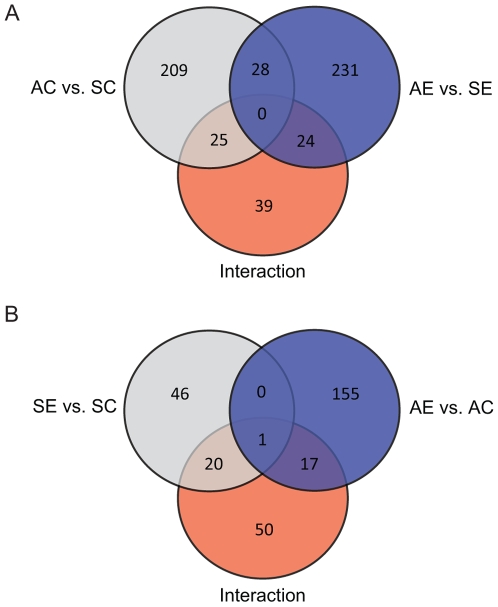
Venn-diagram of regulated cDNA spots in different seasons and with simulated territorial intrusions.A) Number of regulated cDNA spots in autumn compared to spring in either control or STI groups (AC vs. SC, 262 total; AE vs. SE, 283 total), and those that showed interaction effect of season and STI (88 total). B) Number of regulated cDNA spots in STI compared to controls in each season (SE vs. SC, 67 total; AE vs. AC, 173 total), and those that showed interaction effect of season and STI. The numbers within the overlapped circle indicates an overlap of differentially expressed cDNAs. Cell-means model was used for statistics, significant at p<0.01.